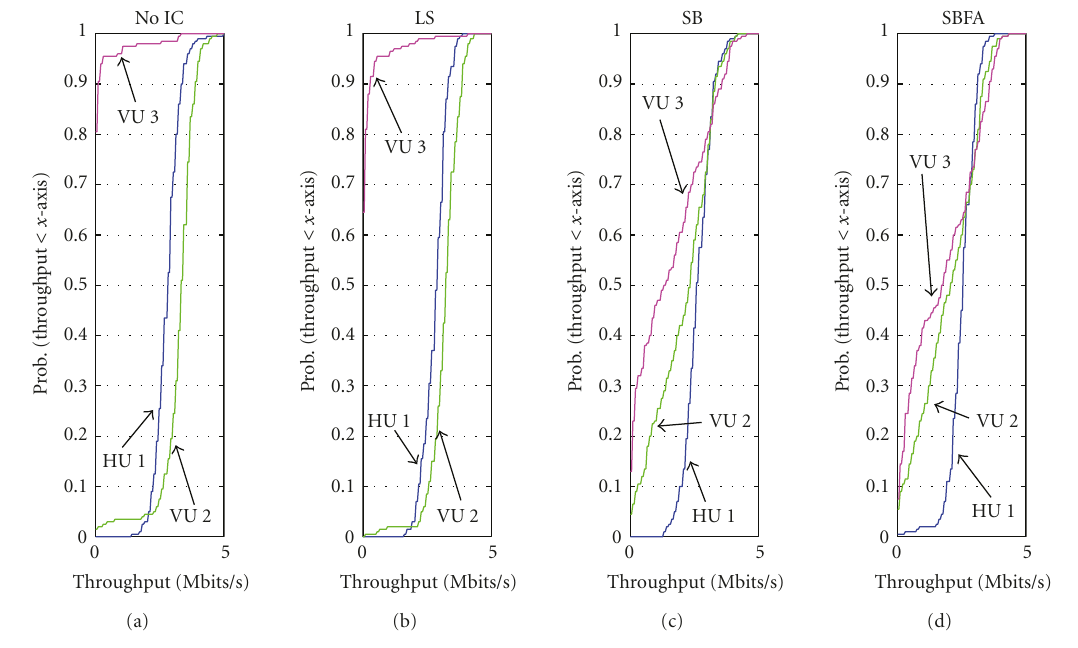
Figure 11: Throughput CDF for the residential scenario of Figure